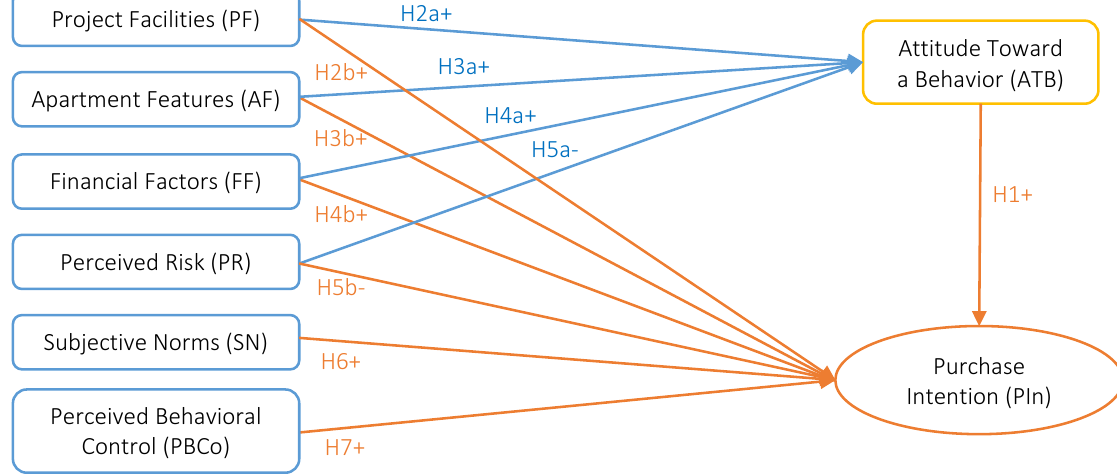
Figure 1. Theoretical